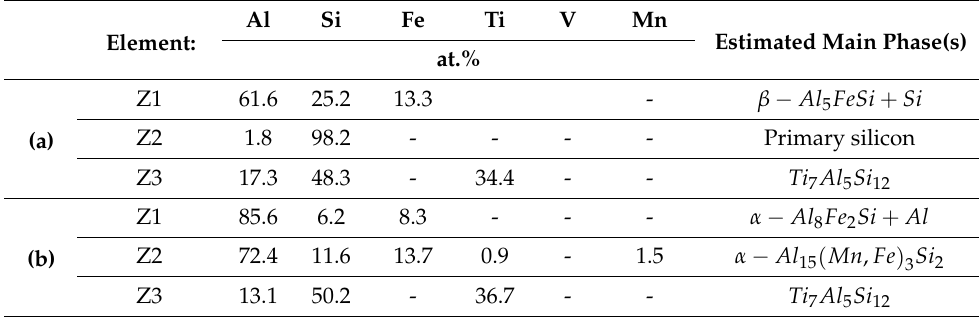
Figure 25. SEM images (SEI) of a brazed joint 9-3/580: ( a ) The active parent part interface with the filler; ( b ) the passive part interface. ((b) is taken at relatively farther distance from the middle of the joint). EDS analyses results are shown in Table 5. Table 4. EDS points analyses for the joint 13/585 presented in Figure 24.